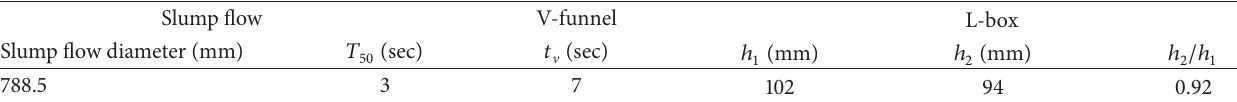
Table 2: Fresh SC-ECC testing.